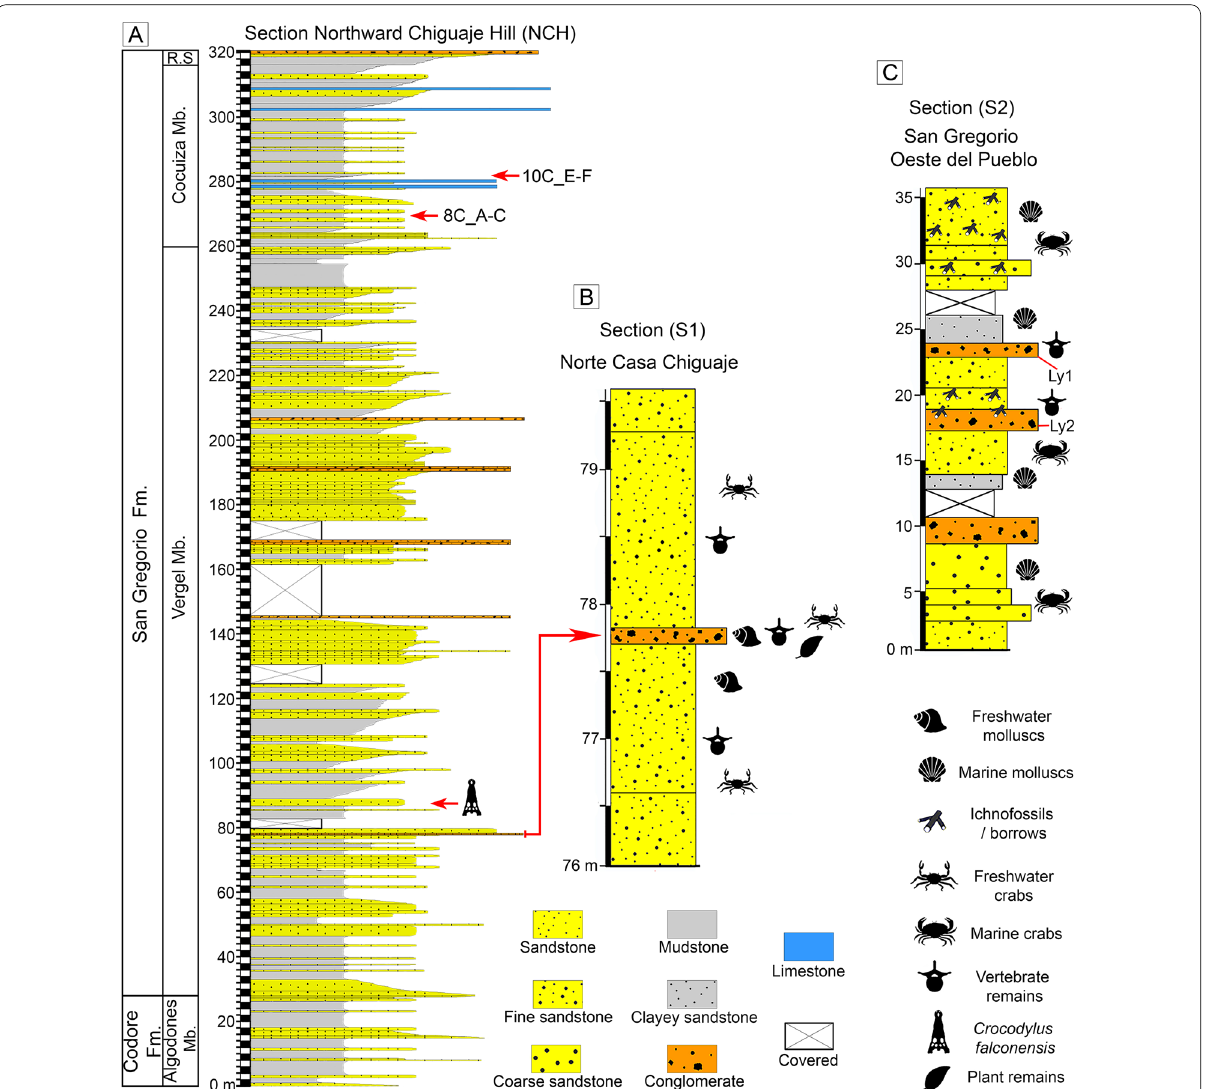
Fig. 3 Stratigraphic context of the San Gregorio Formation. A Generalized section of Northward Chiguaje Hill polygonal (NCH) (see Fig. 1); a section with more detail of the NCH is presented in Additional file 1. B Norte Casa Chiguaje locality section. C San Gregorio Oeste del Pueblo locality section. The “8C_A‑C” and “10C_E‑F” referred in the NCH section correspond molluscan shell samples used for 87 Sr/ 86 Sr analyses (see Additional file 5). Fm. Formation, Mb. Member, R.S Río Seco